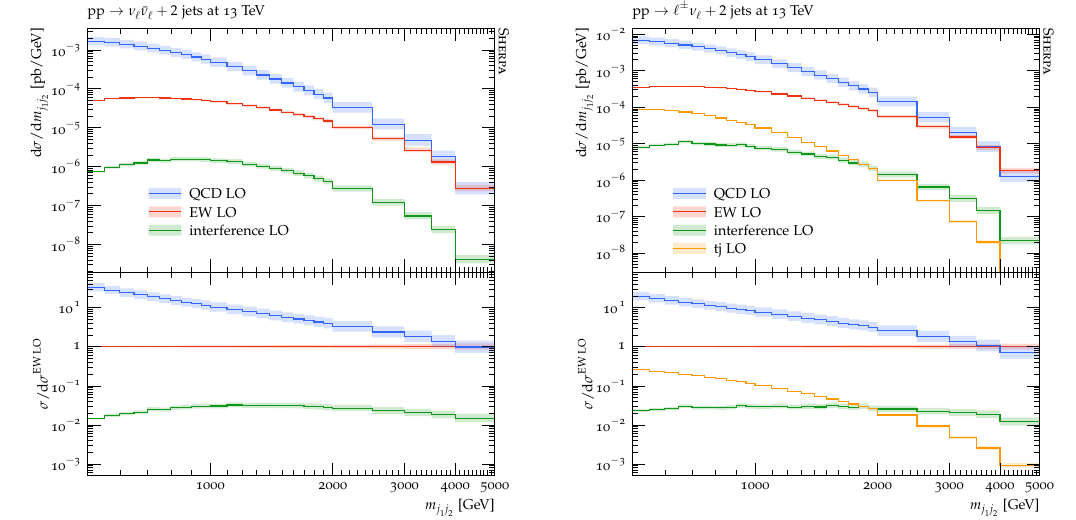
Figure 3. Distribution in the invariant mass of the two hardest jets, m j , for pp → Z ( ν ‘ ¯ ν ‘ )+2 jets 1 j 2 (left) and pp → W ± ( ‘ ± ν ‘ ) + 2 jets (right) at LO. The upper frame shows absolute predictions for the QCD (blue), EW (red), and interference (green) production modes. For pp → W ± ( ‘ ± ν ‘ ) + 2 jets we also show the LO pp → tj contributions (orange), which belong to the EW production mode and include t -channel and s -channel single-top production. The relative importance of the various contributions normalised to the EW production mode is displayed in the lower frame. The bands correspond to QCD scale variations, and in the case of ratios only the numerator is